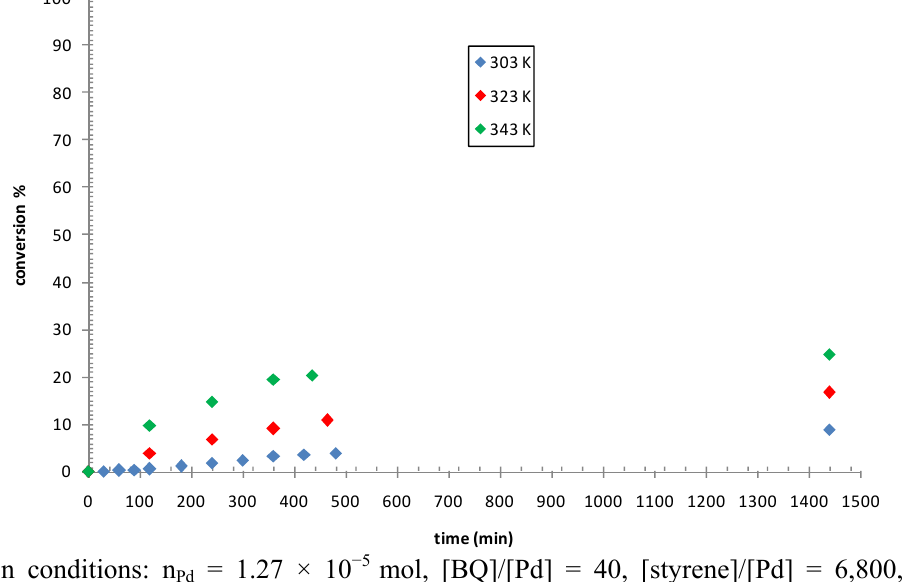
Figure 5. Styrene dimerization: effect of temperature. Precatalyst: 1c .